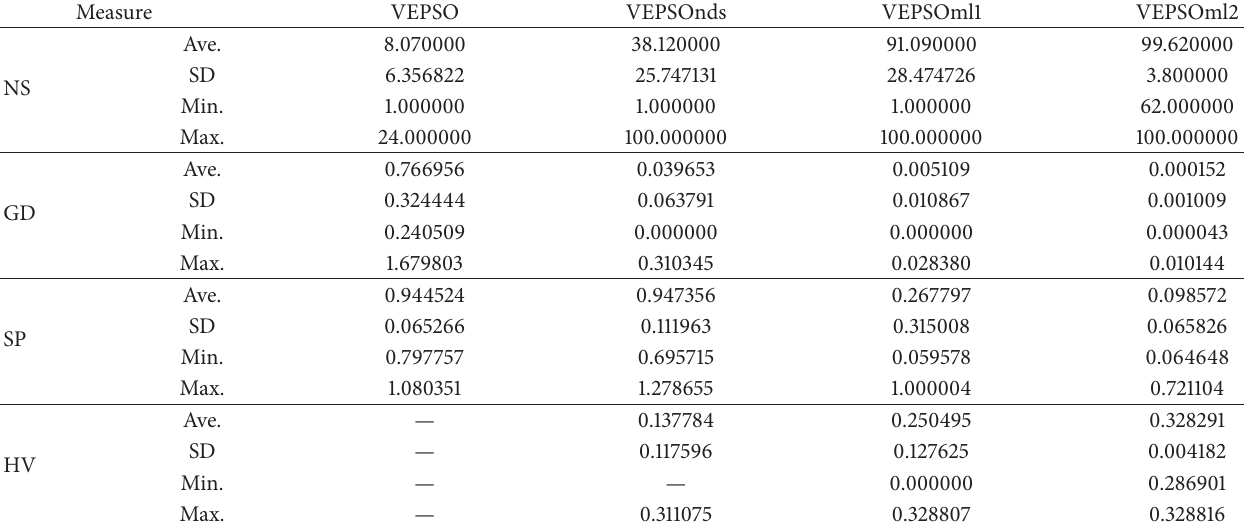
Table 3: Algorithm performance tested on ZDT2